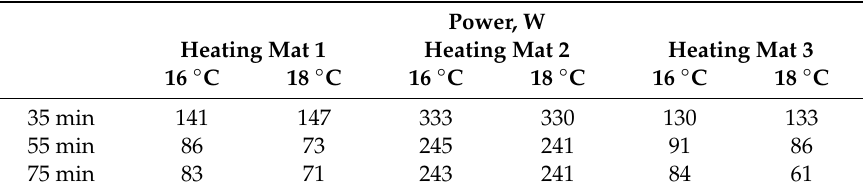
Table 1. Average power settings.